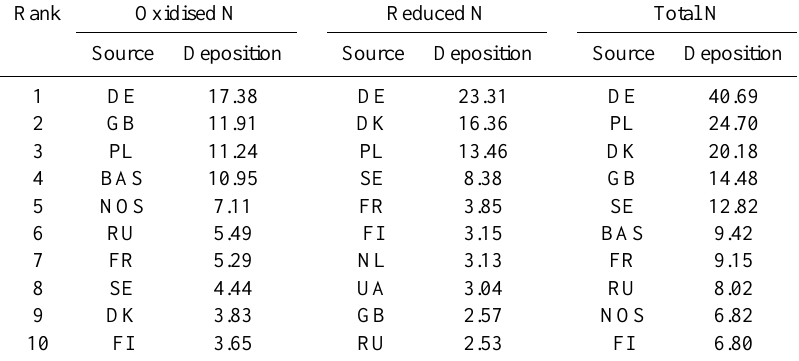
Table 3. Top ten contributors to annual oxidised, reduced and total nitrogen deposition to the Baltic Sea basin averaged over the period 1997–2006. Units:GgN per year. Source codes: DE – Germany, PL – Poland, DK – Denmark, GB – United Kingdom, SE – Sweden, BAS – international ship traffic on the Baltic Sea, FR – France, RU – Russian Federation, NOS – international ship traffic on the North Sea, FI - Finland, NL – The Netherlands. Oxidised